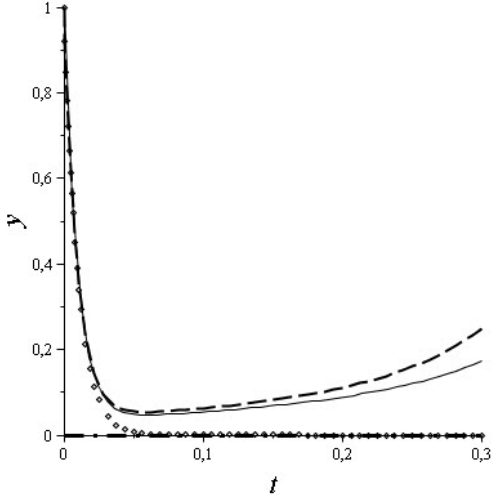
Figure 1. Trajectory y ( t , ε ) with ε = 0.01 and its approximations.